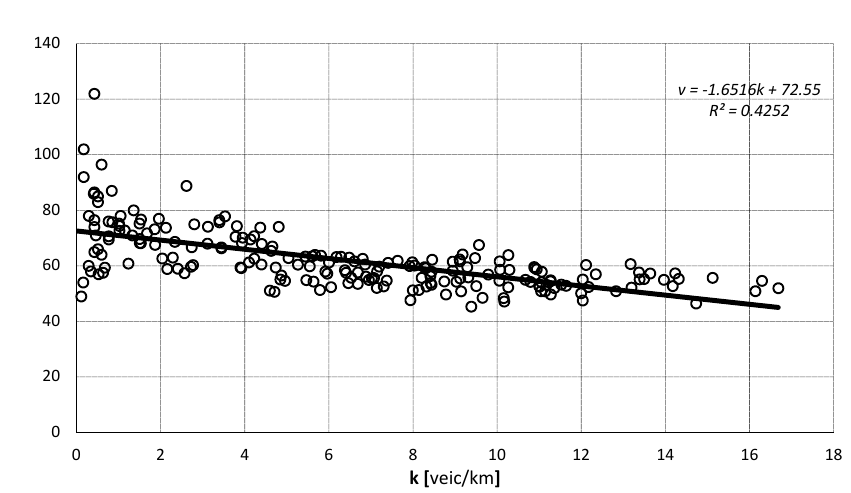
Figure 4. Speed– density scatterplot and speed-function for a link of class 3. The same procedure can be adopted for all link categories.